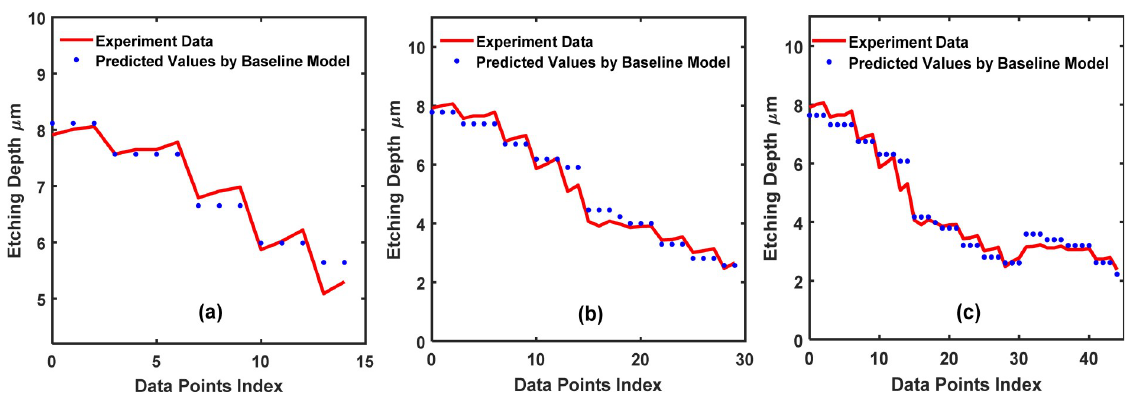
Fig 10. Training dataset fitting for the 2-input dataset using the baseline conventional NN. The partition values, 15, 30, and 45, are shown in (a), (b) and (c), respectively.